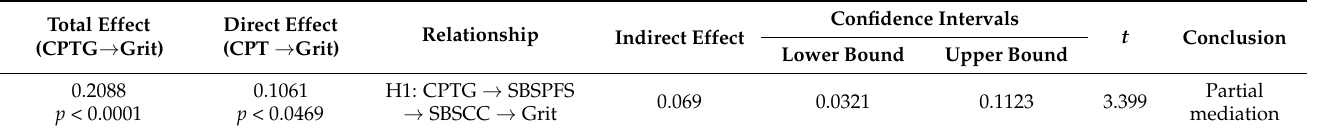
Table 4. Sequential mediation summary.